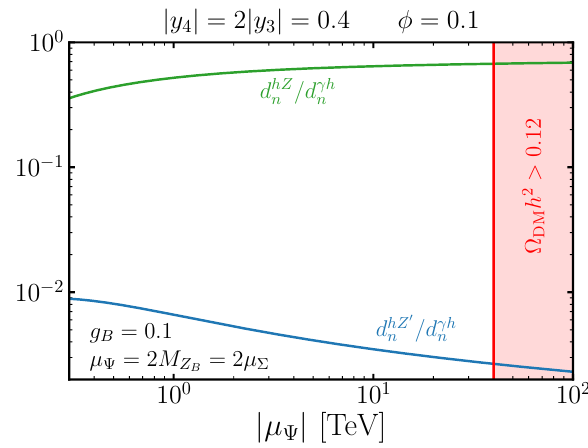
Figure 4 . Ratios of the different contributions to the EDM of the neutron as a function of | µ Ψ | . The other mass parameters are fixed in relation to | µ Ψ | as shown in the figure. The region shaded in light red corresponds to overproduction of dark matter. We have taken zero scalar mixing angle.